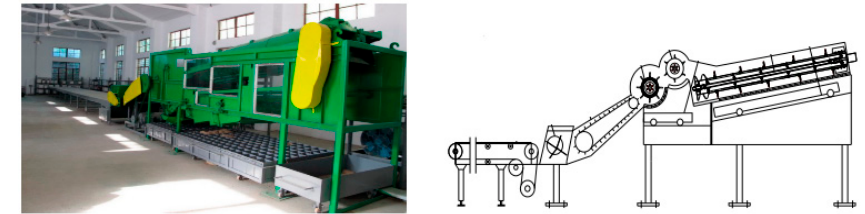
Figure 12. Experimental test bench for threshing-separation–cleaning [47].